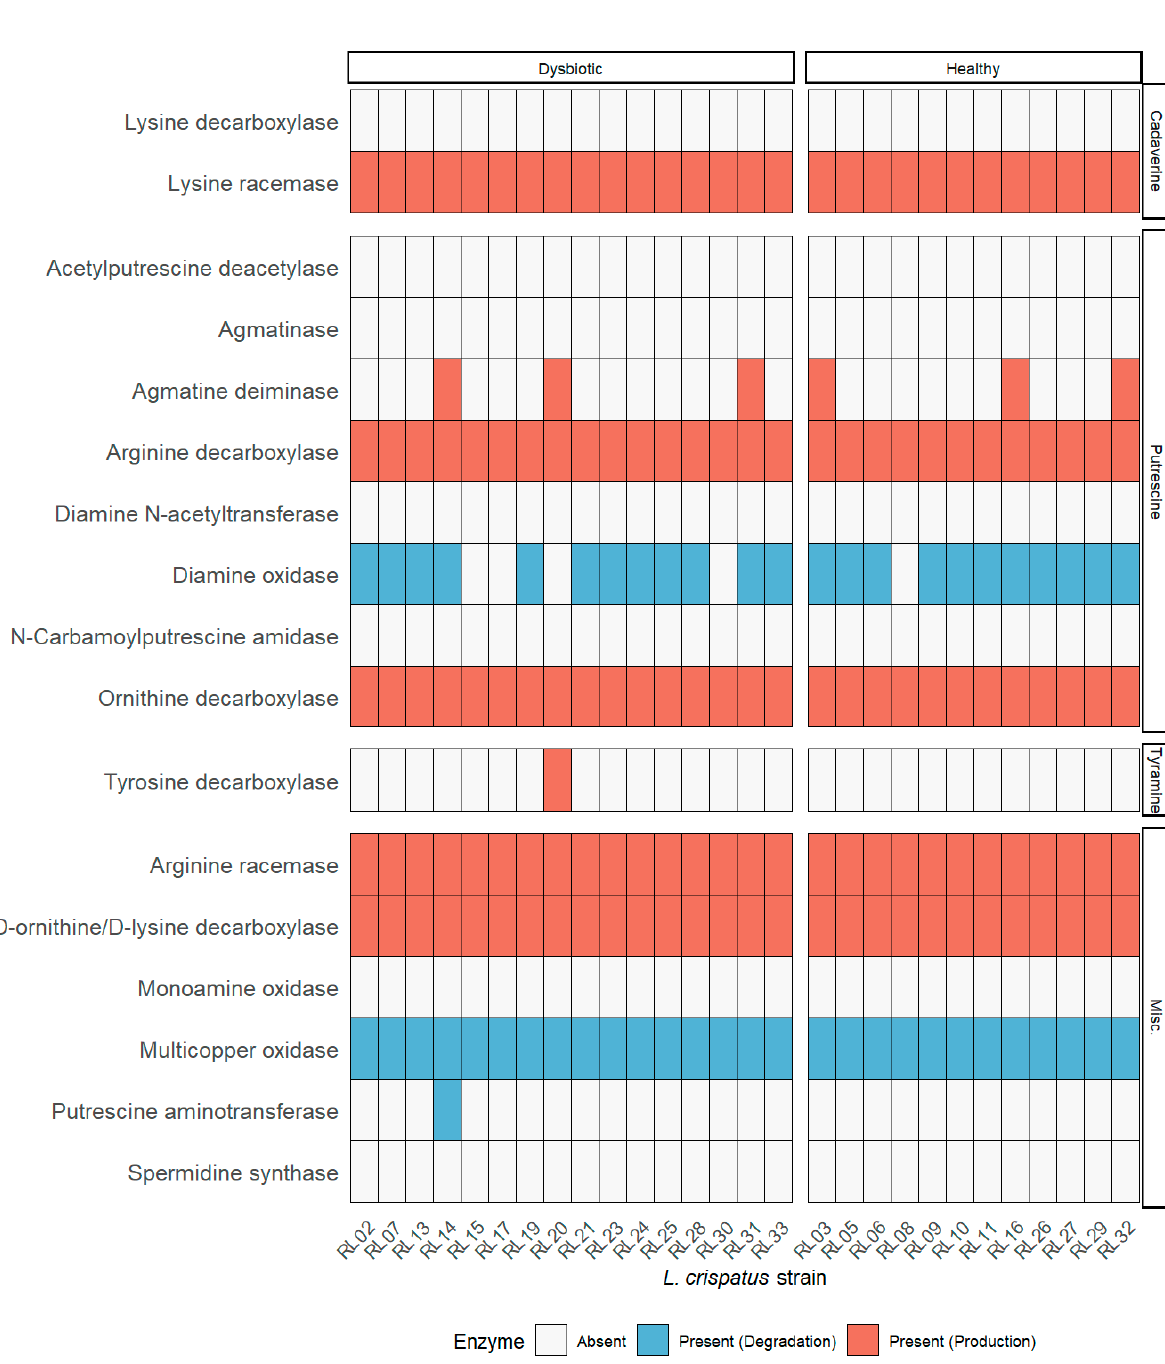
Figure 5. Key enzymes in the metabolism of biogenic amines. Summary of the presence or absence of genes encoding for the enzymes involved in the biosynthesis (red) or degradation (blue) of biogenic amines. All available genomes were used for this analysis.